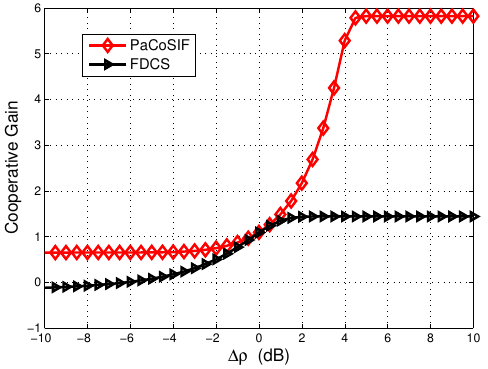
Figure 6. Cooperative gain in spectrum-heterogeneous